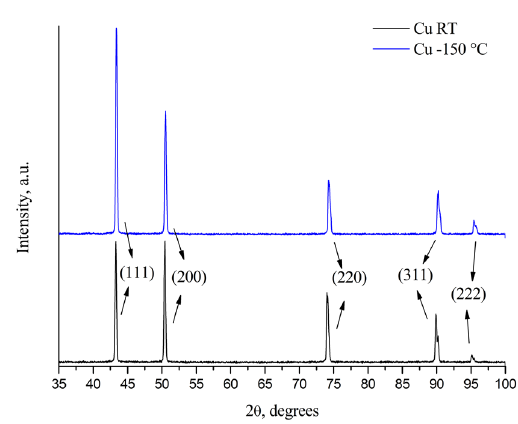
Figure 7. XRD copper rolled at RT and CT. Table 2. Calculated volumetric contraction based on lattice parameter for X-ray diffraction peaks of copper.